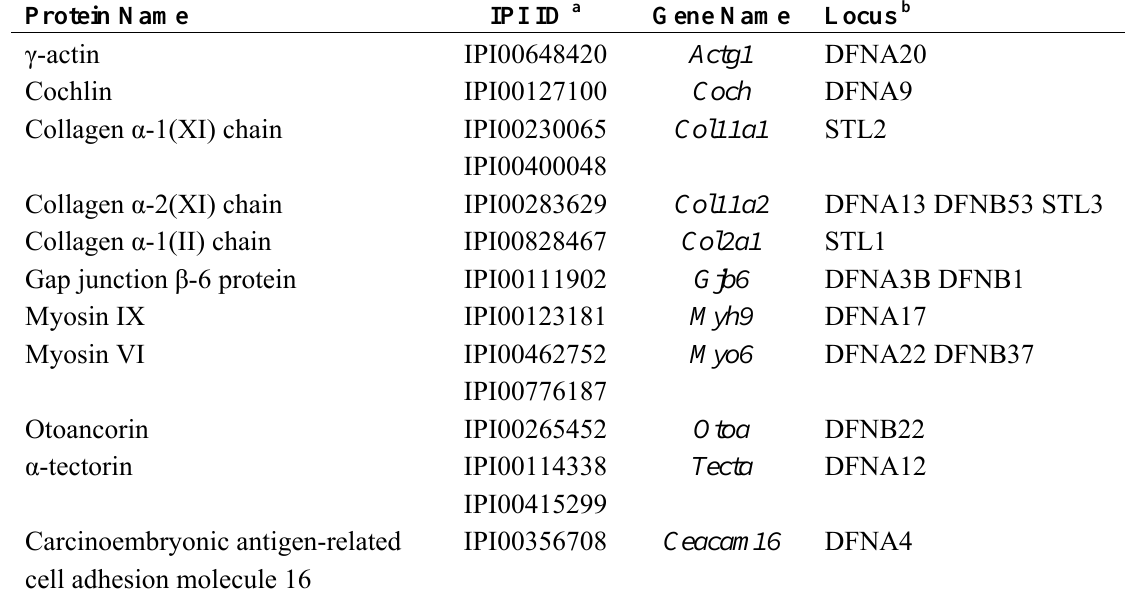
Table 1. Identification of hearing impairment related proteins in the mouse organ of Corti (OC)